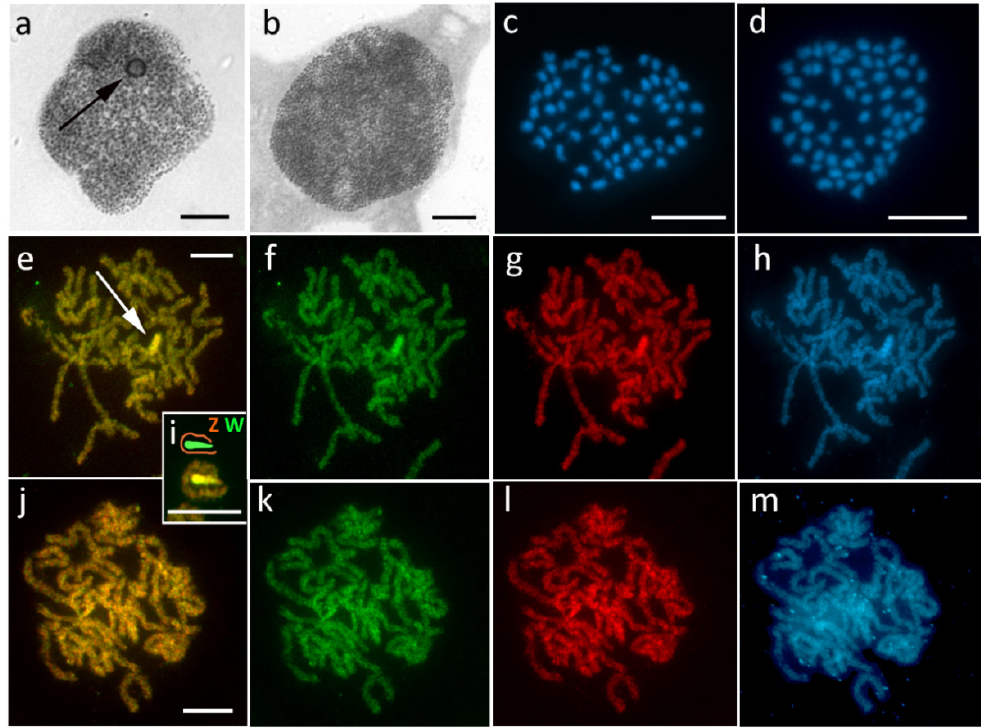
Figure 6. Highly differentiated WZ sex chromosomes in Hypomecis atomaria . ( a , b ) Polyploid nuclei stained with orcein showing a voluminous sex chromatin body in females (( a ), arrow) and missing sex chromatin in males ( b ). ( c , d ) Mitotic metaphase chromosomes stained with DAPI showing 2 n = 62 in both females ( c ) and males ( d ). ( e – m ) Comparative genomic hybridization (CGH) on pachytene chro- mosomes identified in females ( e – i ) a highly differentiated W chromosome (( e ), arrow), composed of prominent DAPI-positive heterochromatin ( h ). In the WZ bivalent, the W chromosome formed a short, thick rod surrounded by a long Z chromosome (( i ), scheme). In males, no chromosome was differentiated by CGH ( j – m ). Panels ( e , i , j )—merged pictures of both probes; ( f , k )—female